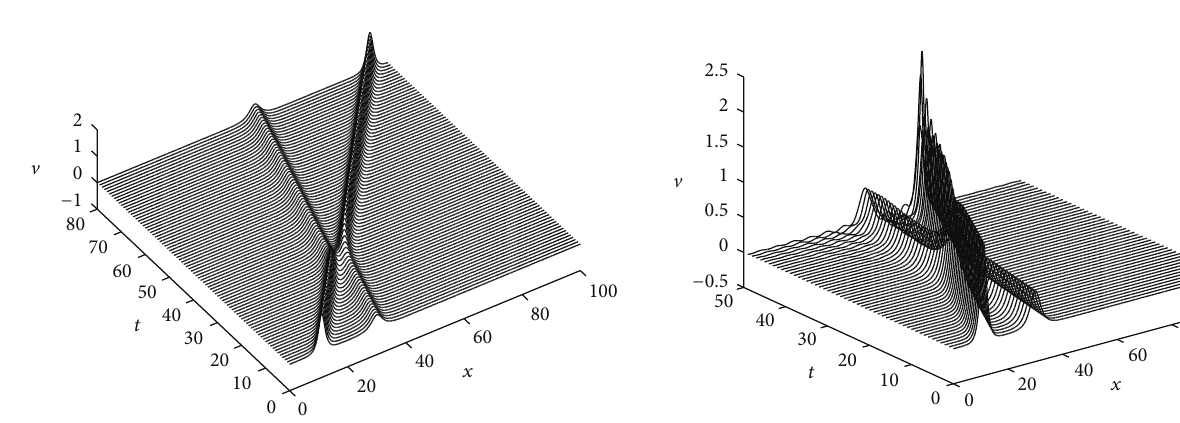
Figure 7: Inelastic interaction: numerical solution 𝑉 𝑛 with 𝑎 = 0.495